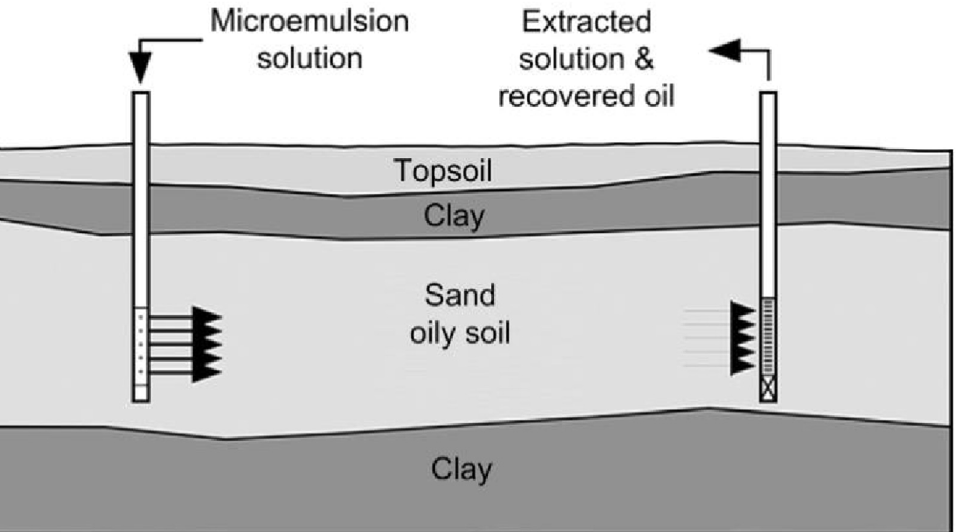
Figure 1. Soil flushing. The first application was enhanced oil recovery. Reprinted with permission from